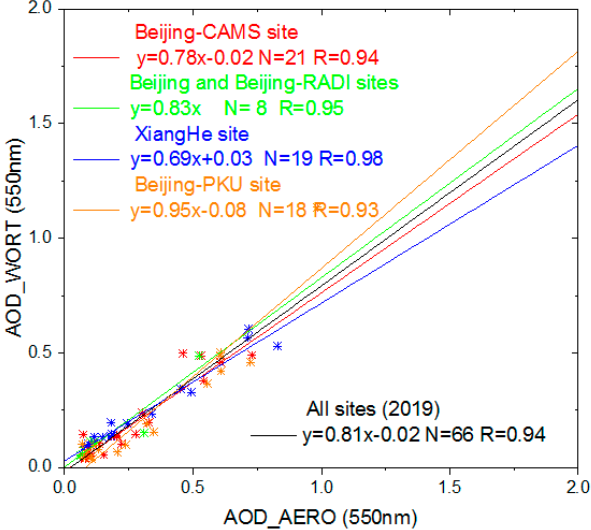
Figure 13. A comparison between ground ‐ measured AOD_AERO and GF ‐ 1/WFV retrieved AOD_WORT in 2019. (Red, green, blue, orange and black symbols represent Beijing ‐ CAMS, Beijing (&Beijing ‐ RADI), XiangHe, Beijing ‐ PKU, and all sites, respectively).